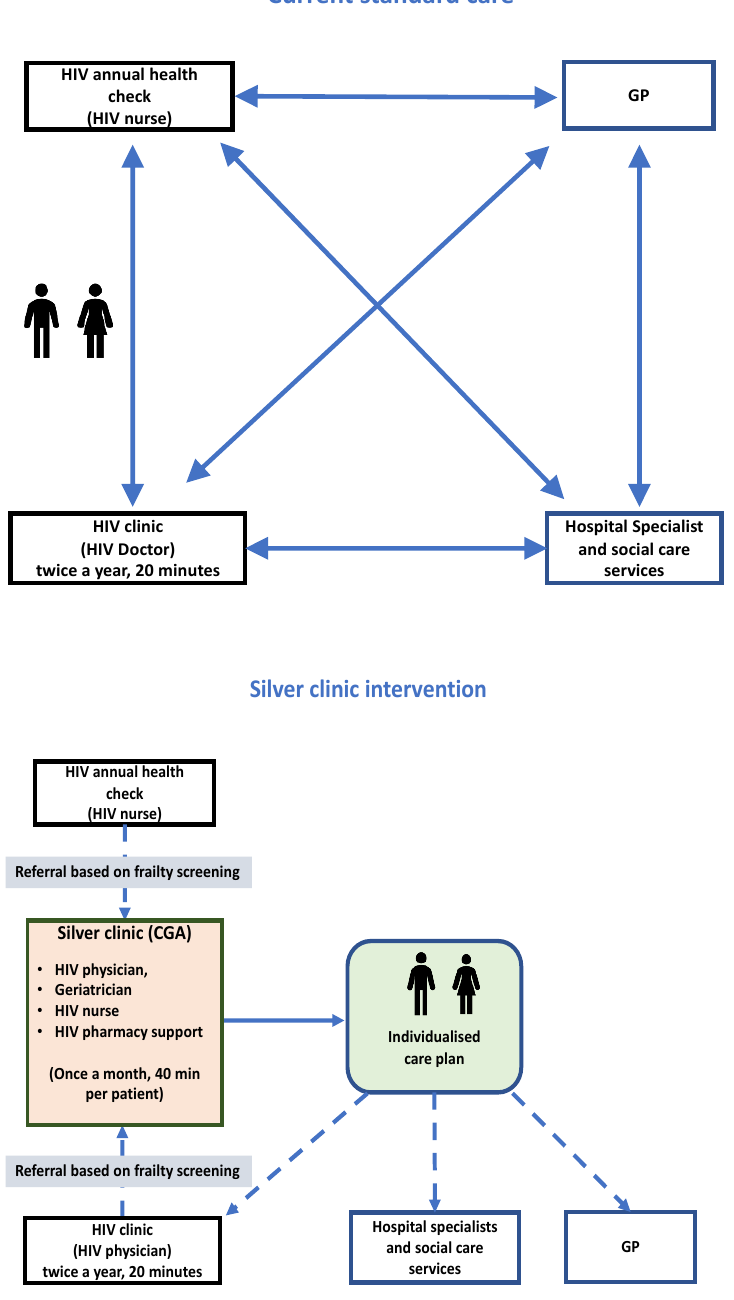
Figure 1. Silver Clinic process and position alongside standard care. Table 1. Clinical assessments performed within the Silver Clinic.